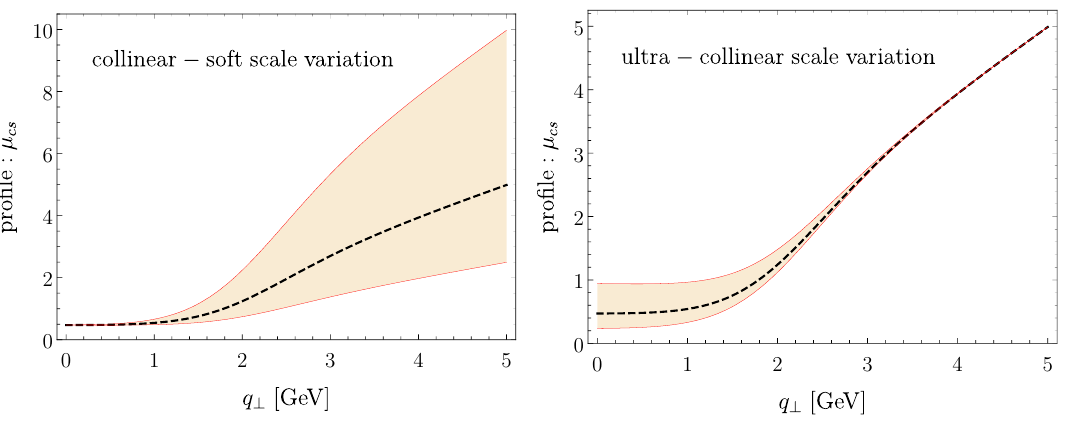
Figure 3 . Pro(cid:12)les in the collinear soft scale (cid:22) S , which smoothly turn o(cid:11) the resummation going from region 2 to region 1. The variation in the pro(cid:12)les probes the error band due to missing higher order